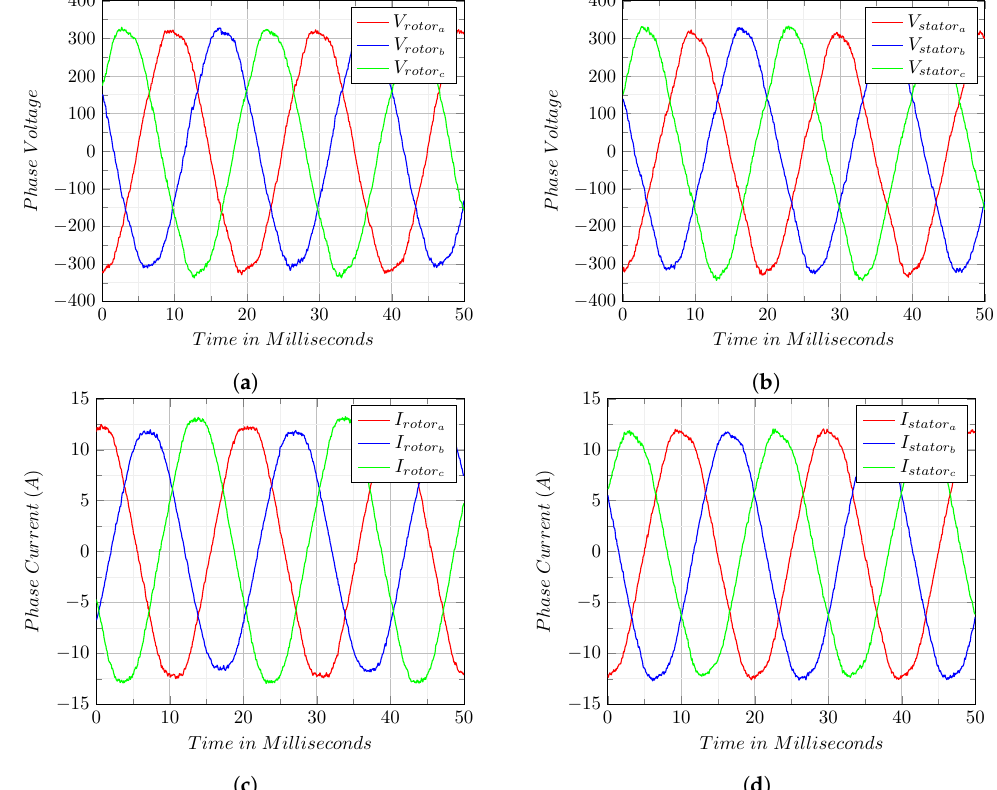
Figure 12. The full-load input and output voltage ( a , b ) and current ( c , d ) waveforms for the three- phase rotary transformer as